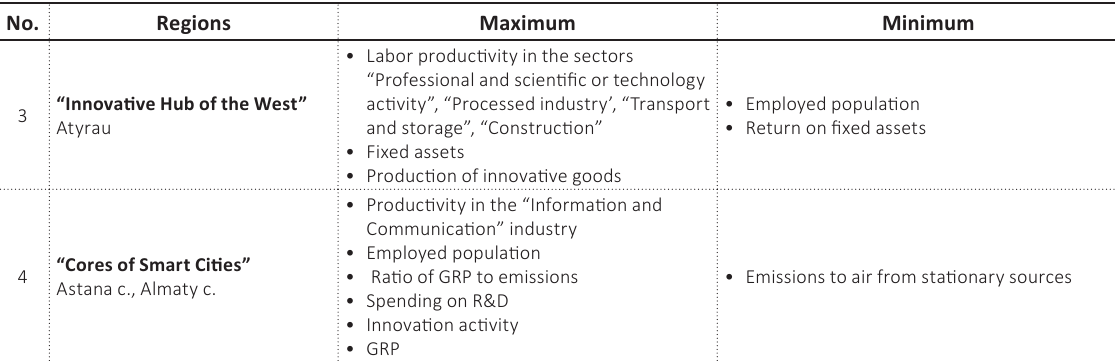
Table 1 (cont.). Description and interpretation of the regional clusters of